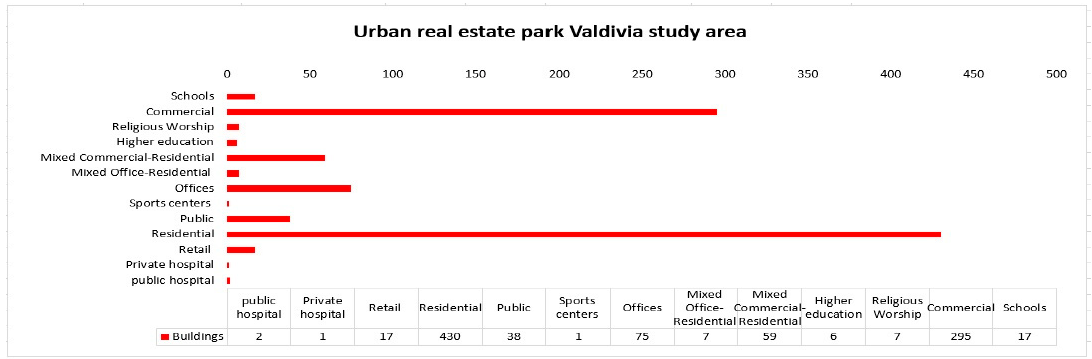
Figure 3. Uses of the real estate park within the study area. Source: Own